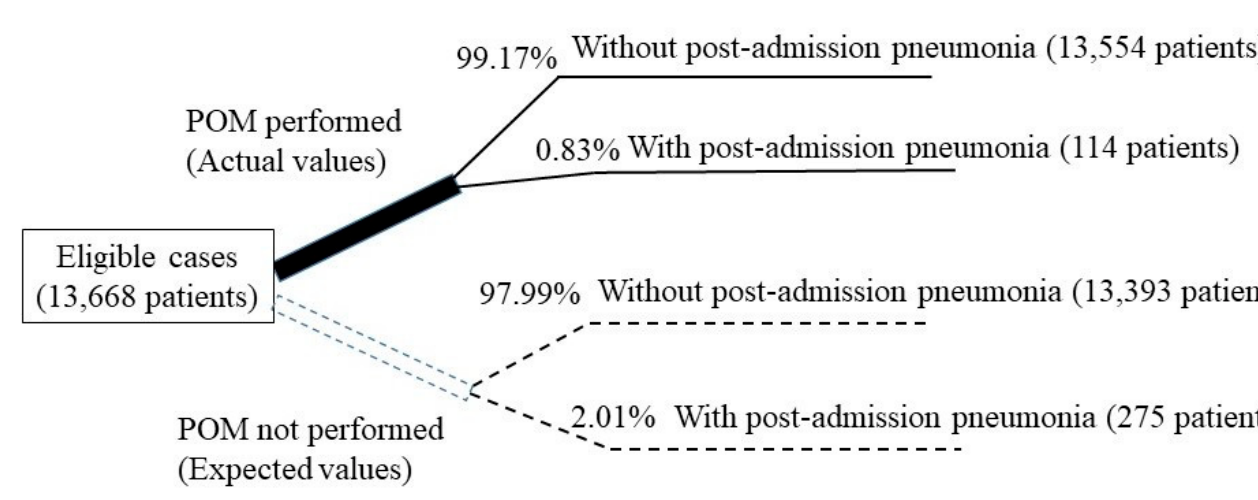
Figure 1. Case distribution and differentiation between the actual and expected values. Actual values are shown as a bold black line and Expected values as a dashed line. Perioperative oral management is abbreviated to POM.